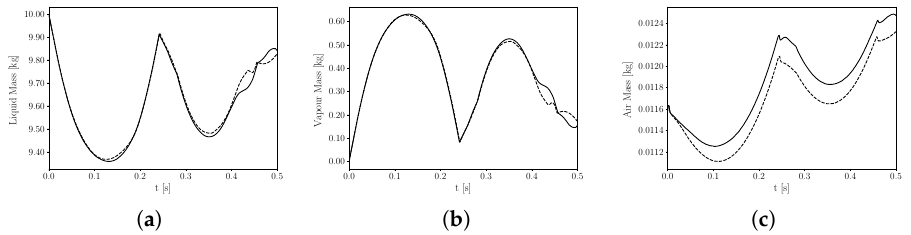
Figure 13. Temporal evolution of the mass for the i -th phase: ( a ) Liquid mass, ( b ) Vapour mass, ( c ) Air mass. Legend: ( ) grid A (1